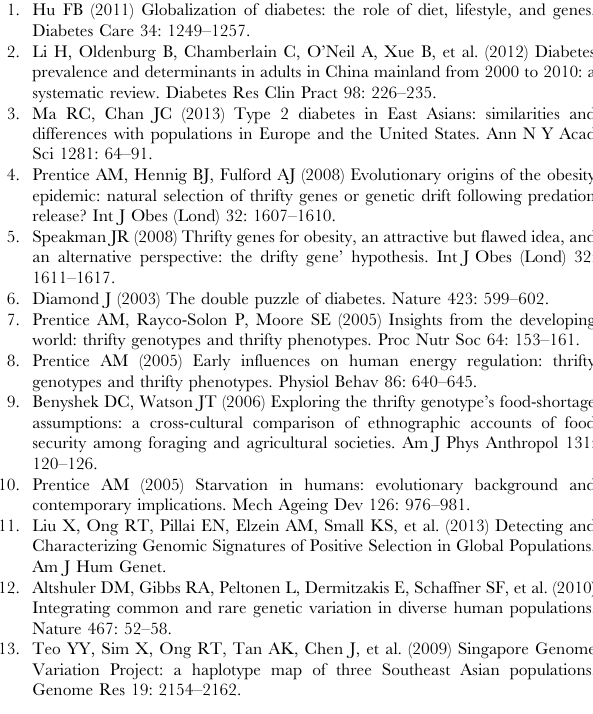
S2. Figure S1. Long haplotype forms that exhibit evidence of positive selection on chromosome 10 and chromosome 15. Table S1. Candidate index SNPs associated with Type 2 diabetes used in the study. Table S2. Candidate index SNPs associated with obesity used in the